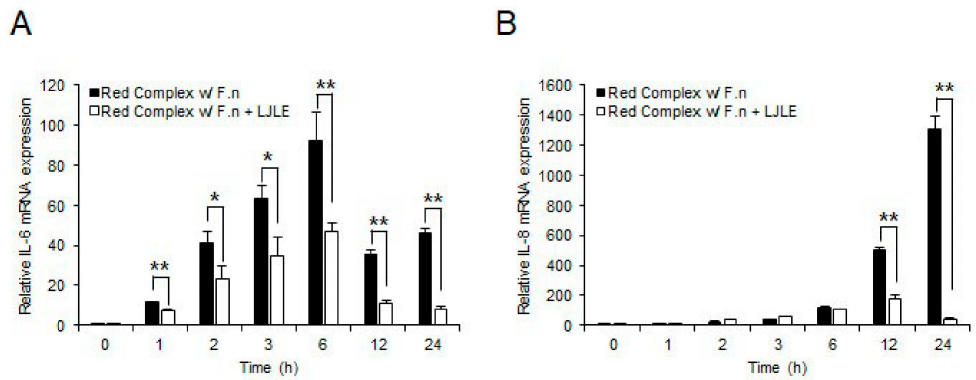
Figure 4. LJLE inhibits pro-inflammatory cytokine expression in mixed red complex bacteria, including F. nucleatum (F.n)-infected human PDLFs. Human PDLFs were stimulated with LPS in the absence or presence of 100 μ g/mL LJLE for different times (0, 1, 2, 3, 6, 12, and 24 h). Real-time PCR was performed as described in the Materials and Methods. ( A ) Time-course of effects of LJLE on IL-6 and ( B ) IL-8 mRNA expression in mixed red complex ( P. gingivalis , T. denticola , and T. forsythia ), including F. nucleatum (F.n)-infected PDLFs. * p < 0.05 and ** p < 0.01 compared with bacterial infection alone